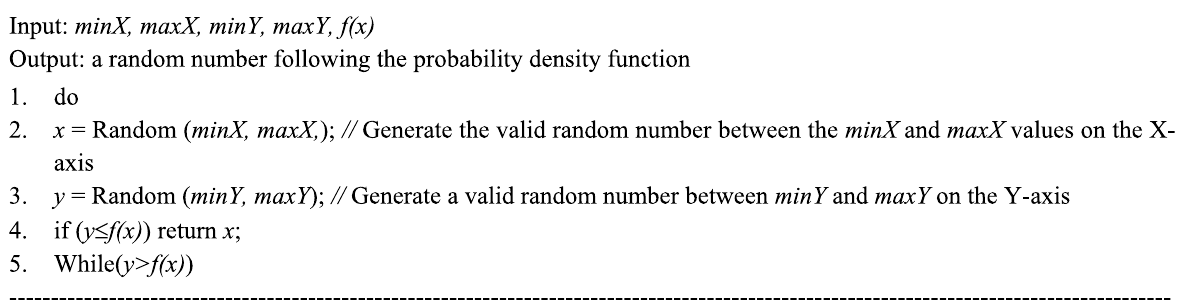
Our experiment uses the Monte Carlo method to gen- erate random numbers as service input parameters or